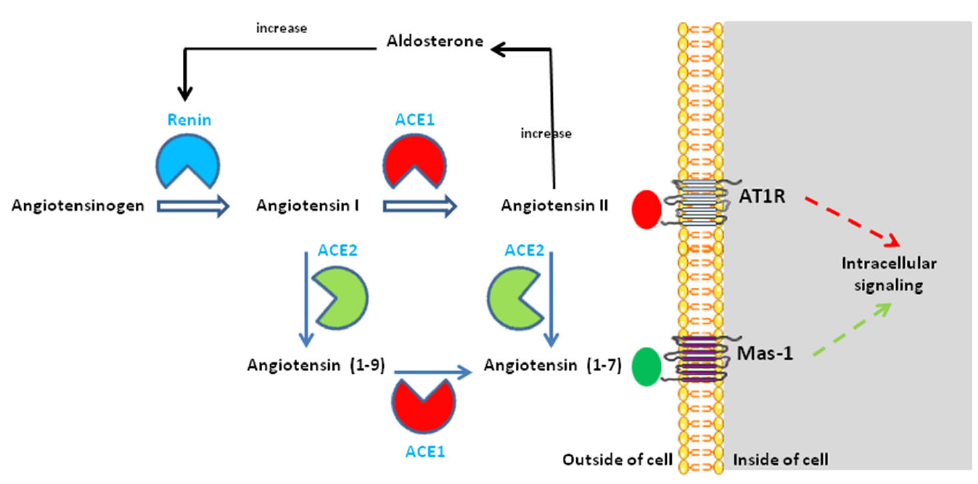
Figure 1. Structure of the renin–angiotensin–(aldosterone) system and the role of ACE2 in this physiological system. ACE1 catalyzes the conversion of angiotensin I (Ang I) to angiotensin II (Ang II). ACE2 catalyzes the conversion of Ang I to angiotensin-(1-9) and the conversion of Ang II